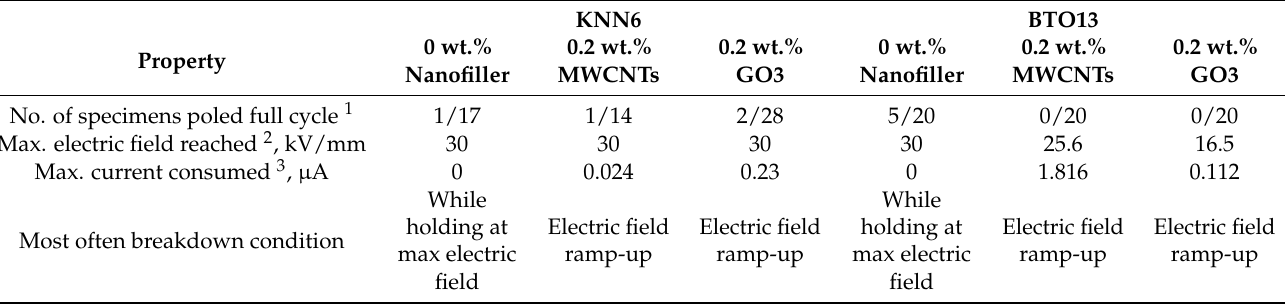
Table 1. Results of composite